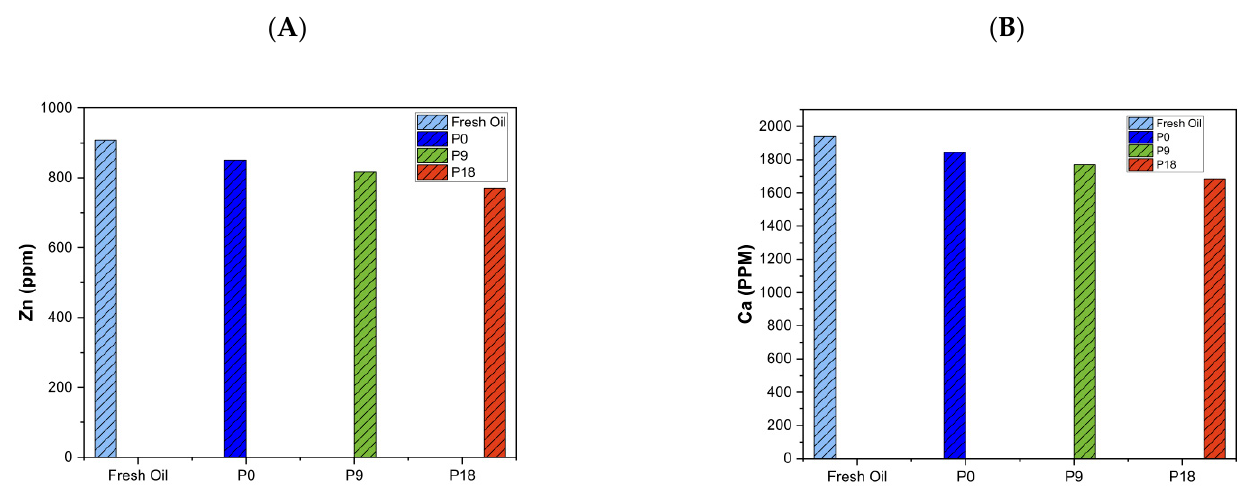
Figure 4. ( A , B ) Comparison of zinc and calcium for various lubricant